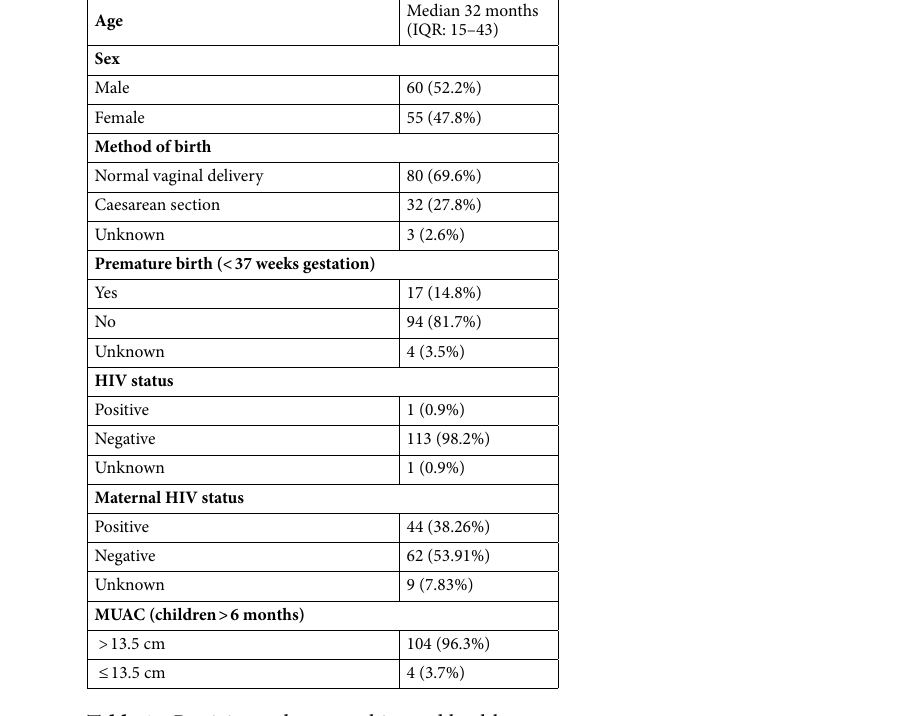
Table 1. Participant demographics and health